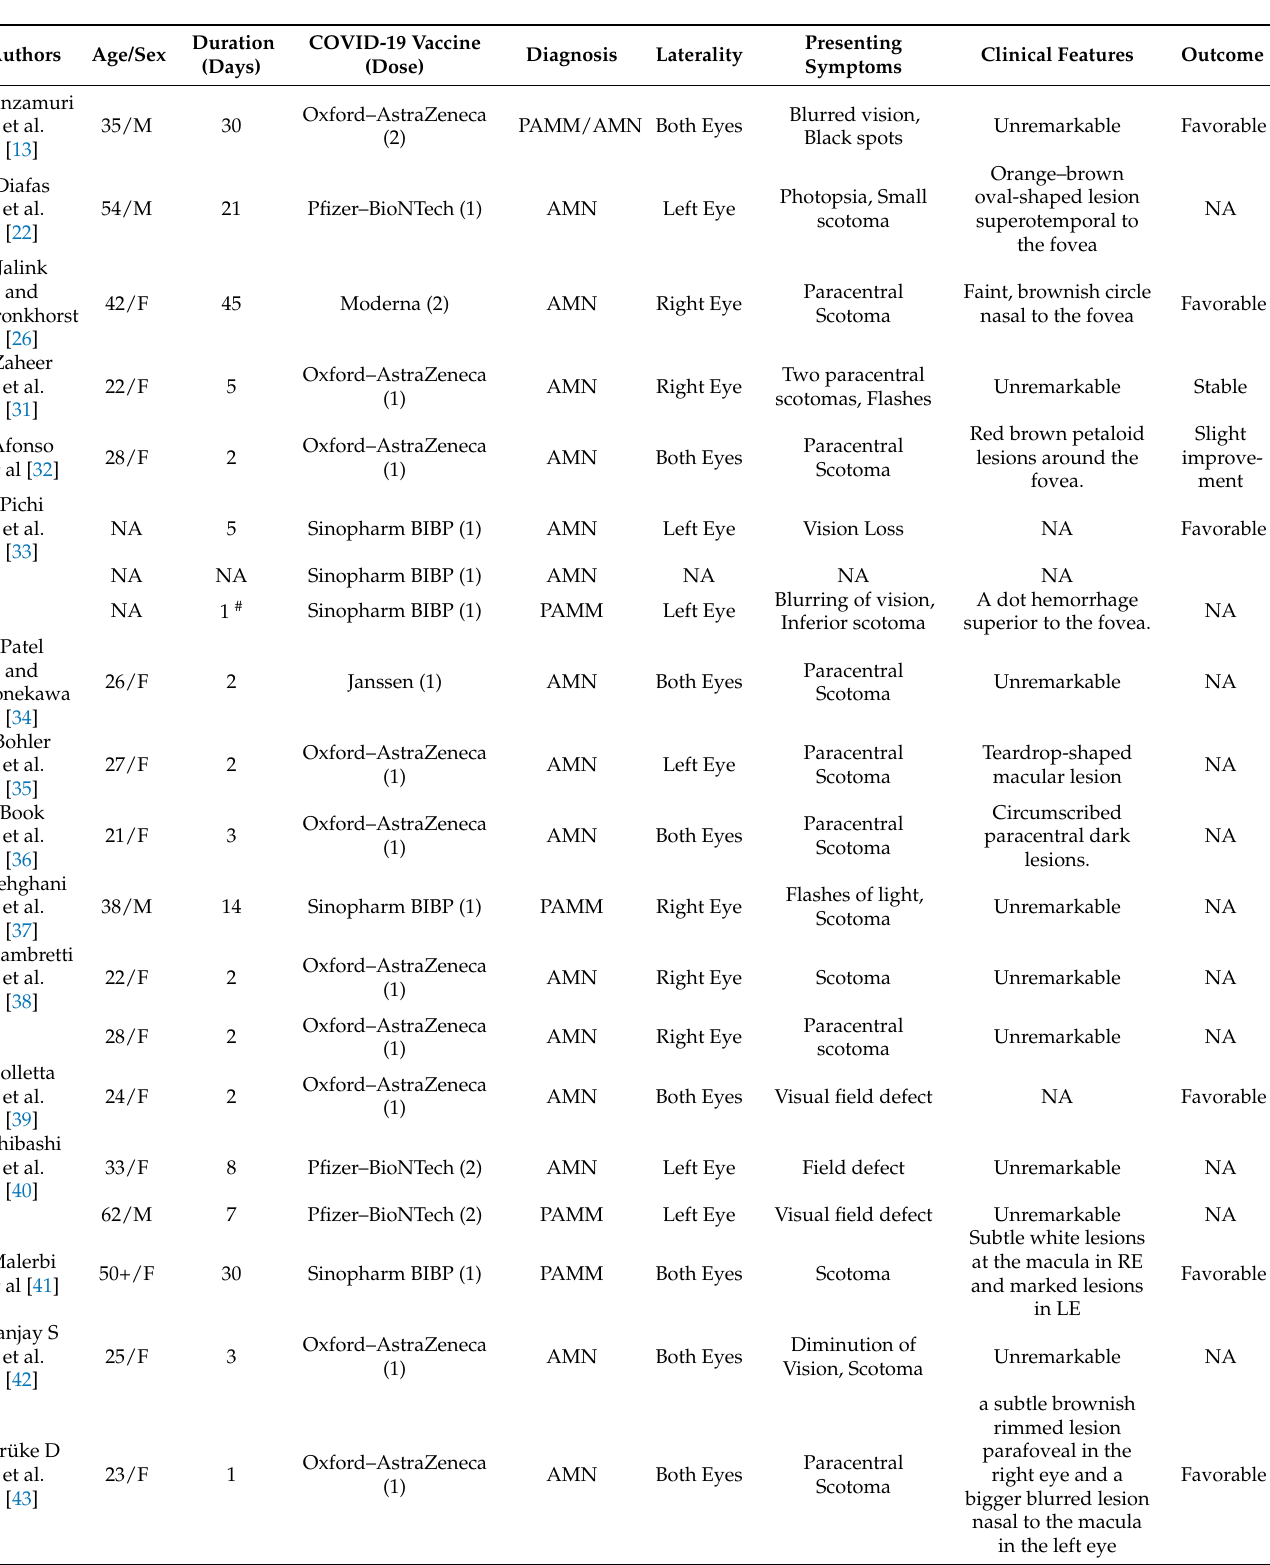
Table 2. Review of Literature of Cases with AMN and PAMM cases in patients following COVID-19